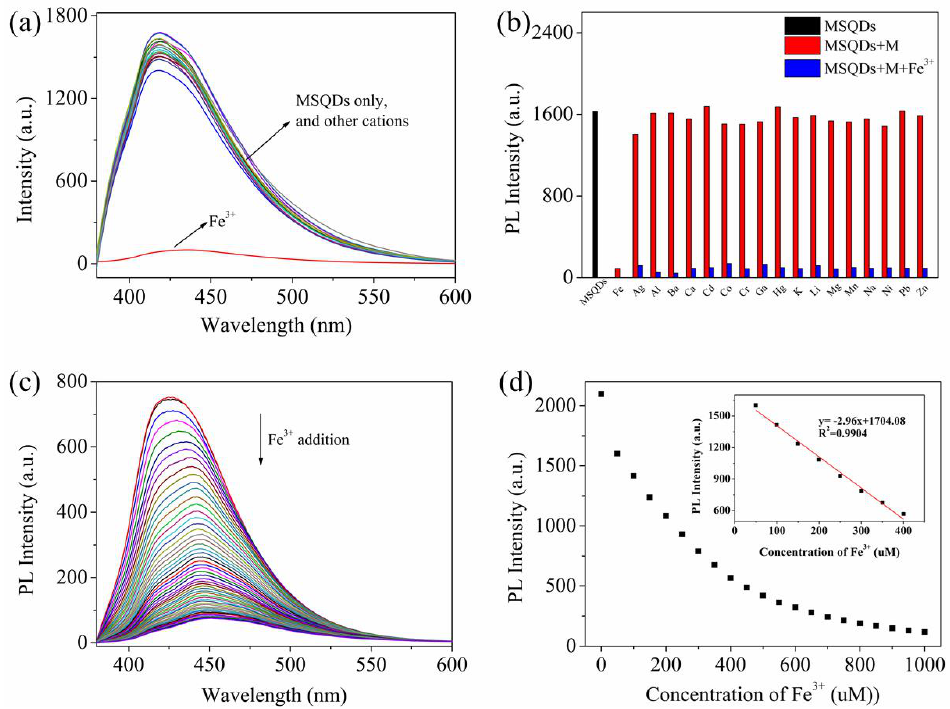
Figure 6. ( a ) Fluorescence spectra of WS-MSQDs upon addition of various metal ions (Fe 3+ , Ag + , Al 3+ , Ba 2+ , Ca 2+ , Cd 2+ , Co 2+ , Cr 3+ , Ga 3+ , Hg 2+ , K + , Li + , Mg 2+ , Mn 2+ , Na + , Ni 2+ , Pb 2+ and Zn 2+ ). ( b ) Relative fluorescence intensities of WS-MSQDs at 425 nm. (black bars: WS-MSQDs; red bars: WS-MSQDs with other metals; blue bars: WS-MSQDs with other metals ions and Fe 3+ ions). ( c ) Fluorescence spectra of WS-MSQDs in the presence of different concentration of Fe 3+ ions. ( d ) Fluorescence intensity of WS-MSQDs versus increasing concentrations of Fe 3+ ions. Inset of ( d ): The linear changes of fluorescence intensity of WS-MSQDs at 425 nm upon titration with Fe 3+ ions. All spectra were acquired in HEPES (10 mM, pH 7.2) buffer solution at room temperature. [WS-MSQDs]= 10 μg/mL, λ ex = 340 nm, Slit: 5.0 nm/5.0 nm.